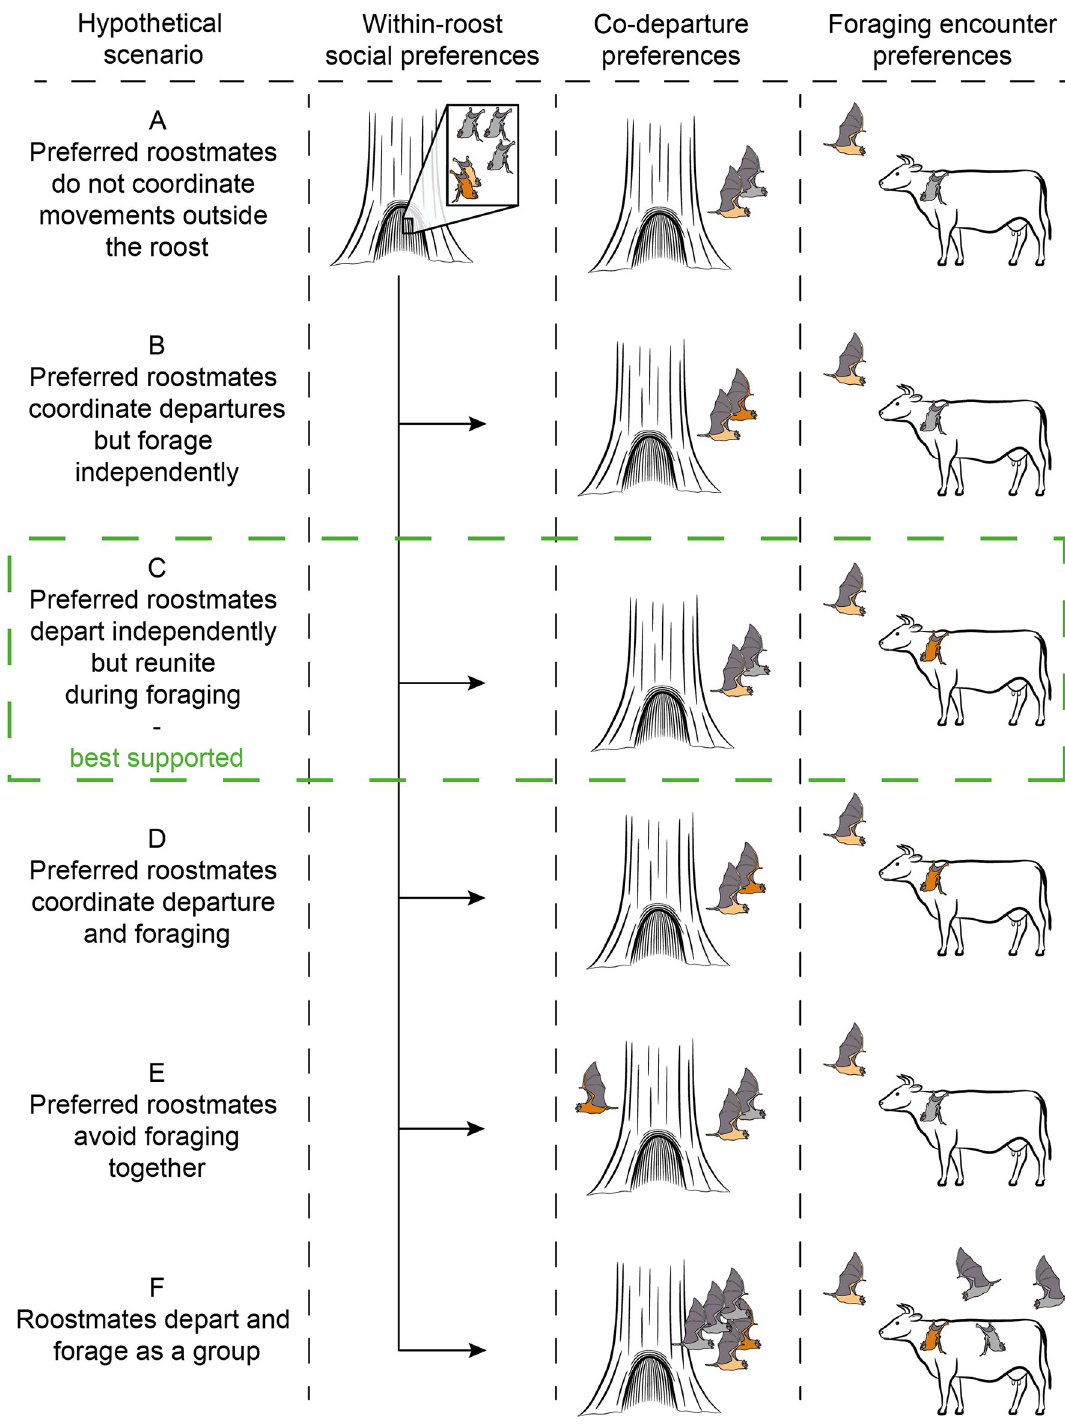
Fig 1. Hypothetical scenarios for how within-roost relationships could predict foraging. For the same roosting association networks, each scenario predicts different outcomes for how preferred within-roost relationships correlate with co-departures or encounters during foraging. Preferred roostmates (shown as pair of light brown and dark brown bats) might either (A) not coordinate their behavior outside the roost, (B) coordinate only their departures, (C) depart independently and reunite during foraging, (D) coordinate departures and foraging, or (E) avoid foraging together. Alternatively, the bats could (F) depart and forage as a large group.